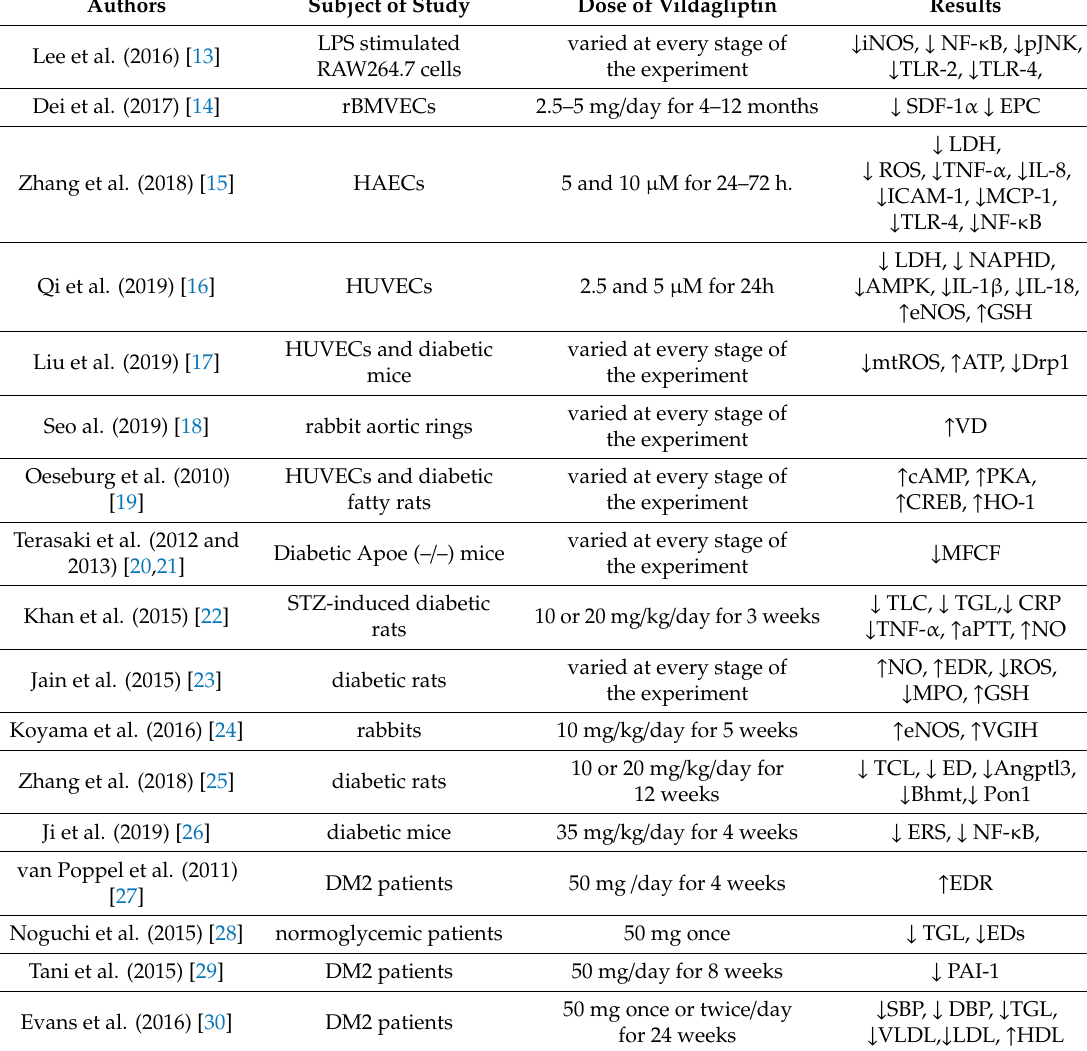
Table 1. Summary of reviewed